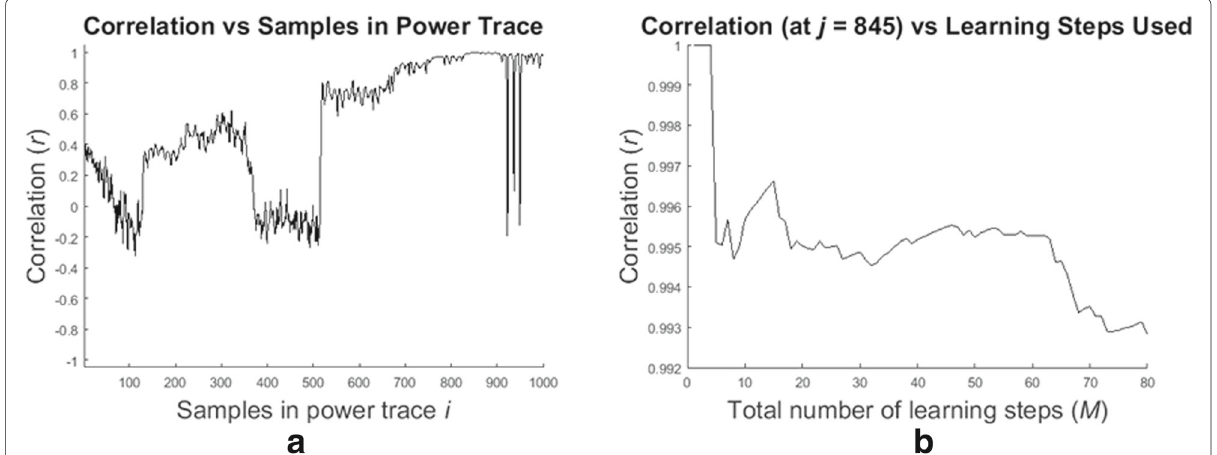
Fig. 9 CPA in MIMPA. Correlation coefficient plots with respect to a the samples and b the learning